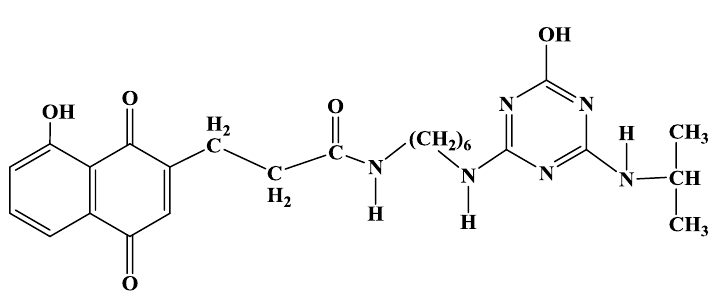
Figure 13. JUG-HATZ